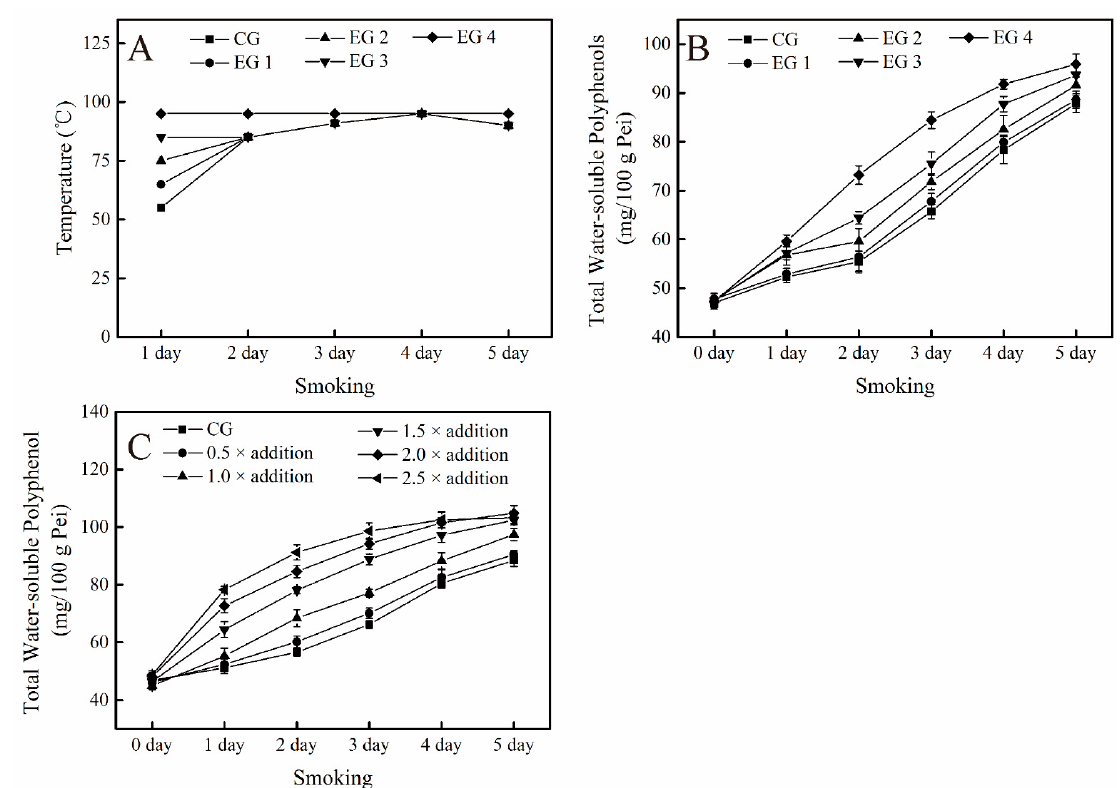
Figure 4. Single-factor experiment of environmental factors affecting the content of polyphenols: ( A ) temperature control process in temperature single factor experiment, ( B ) influence of temperature on the content of total water-soluble polyphenols, and ( C ) influence of external sources on the content of total water-soluble polyphenols.